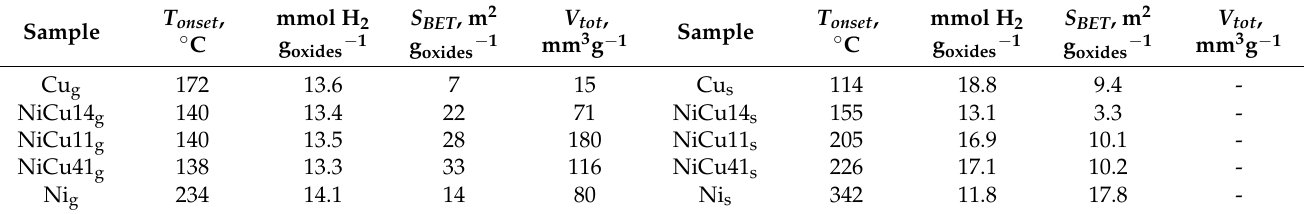
Table 4. T onset and H 2 consumption during TPR measurements together with surface area S BET and total pore volume V tot of the granular and sputtered Ni-Cu